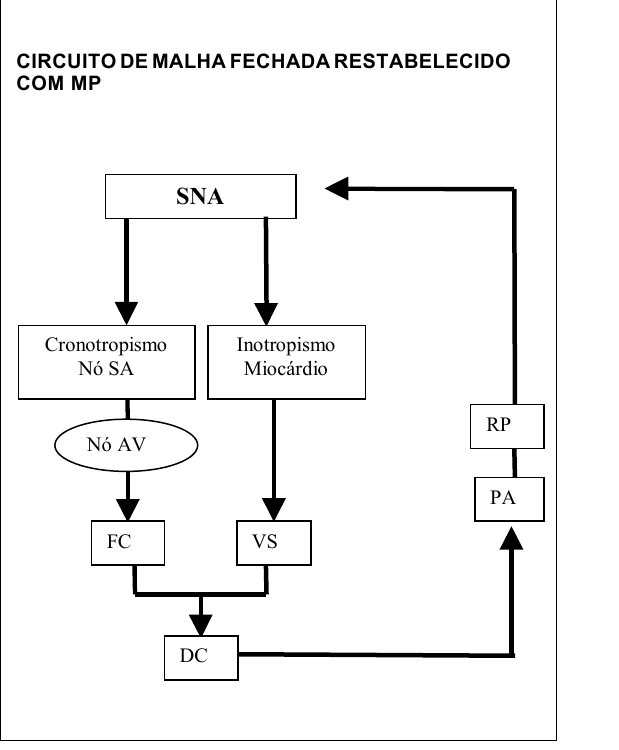
Fig. 2 – Esquema do controle autônomo do DC através da FC (via cronotrópica) e VS (via inotrópica).